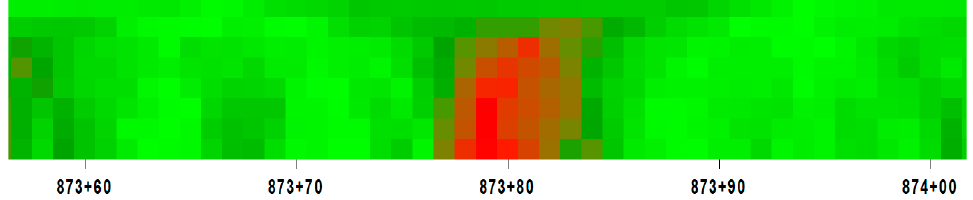
Figure 2. A subset of the rail alignment values measured on the two rails by color scale.